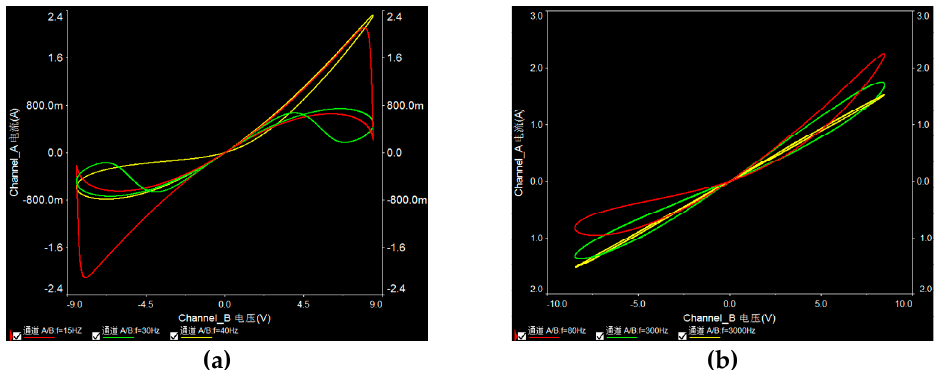
Figure 3. Multisim simulations of pinched hysteresis loops of the AM emulator under an applied sinusoidal input with different frequencies: ( a ) f = 15 Hz, f = 3 0 Hz, and f = 40 Hz; ( b ) f = 80 Hz, f = 300 Hz, and f = 3000 Hz.